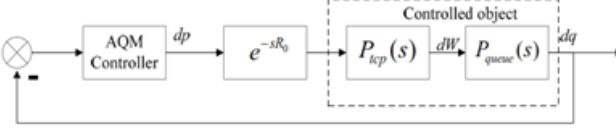
Figure 3. Flow chart of the control system